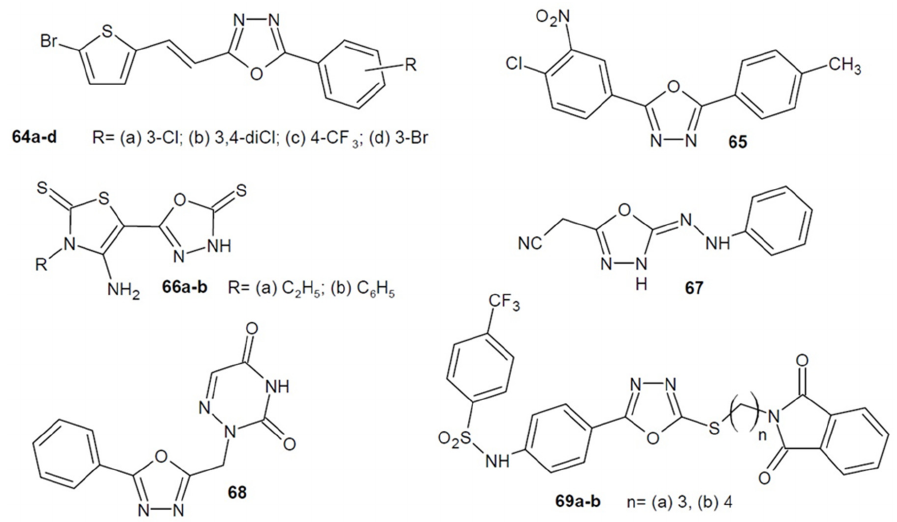
Figure 22. 1,3,4-oxadiazole derivatives with antiviral activity.